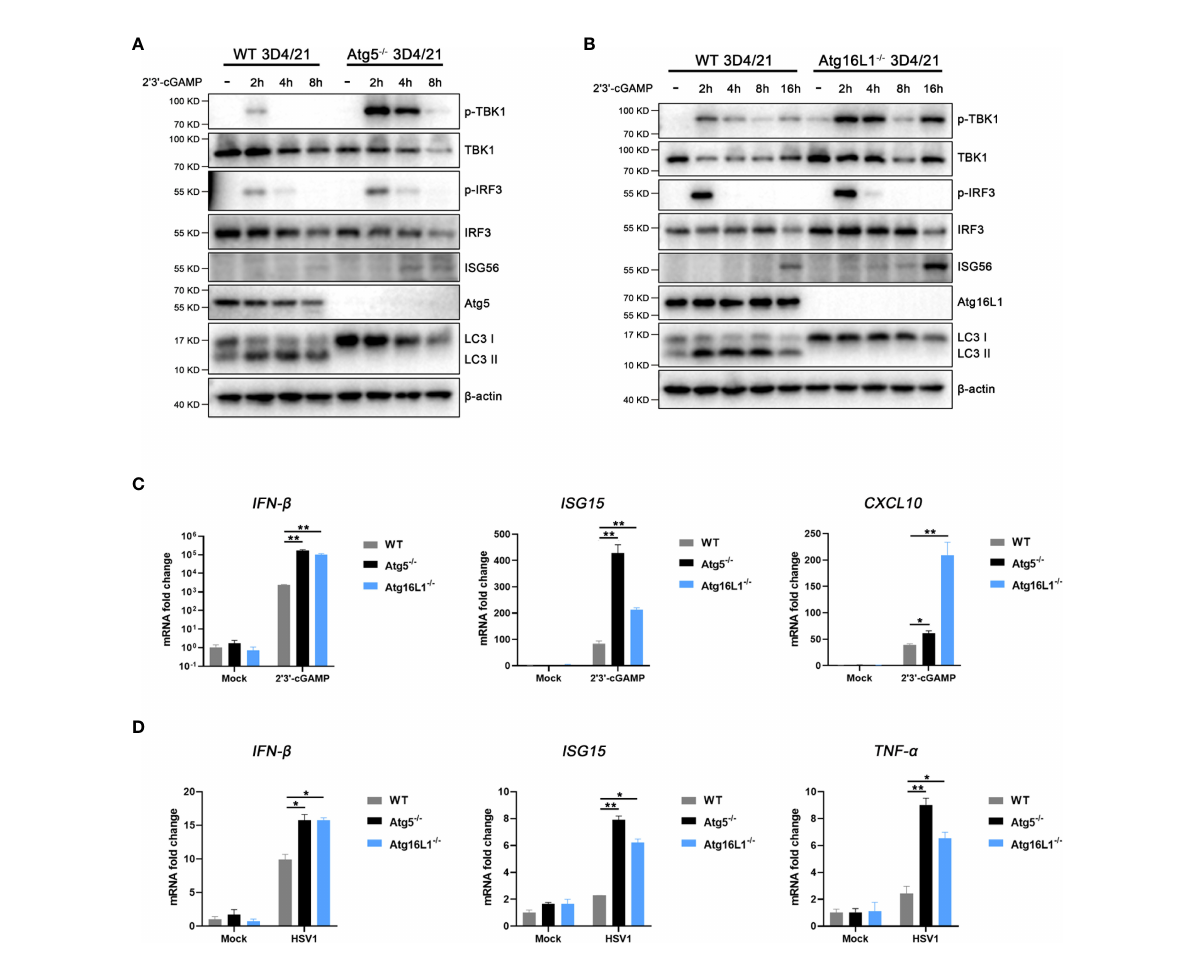
FIGURE 6 STING induced autophagy suppresses IFN signaling. (A, B) Wild type and Atg5 -/- 3D4/21 cells (A) or Atg16L1 -/- 3D4/21 cells (B) were stimulated by transfection of 2 ’ 3 ’ -cGAMP (1 m g/mL) for the indicated times, and cell lysates were analyzed by Western blotting with the indicated antibodies. (C, D) Wild-type, Atg5 -/- and Atg16L1 -/- 3D4/21 cells were stimulated with 2 ’ 3 ’ -cGAMP (1 m g/mL) for 4h (C) or infected with HSV1 (0.01 MOI) for 8 h (D) . The harvested cells were analyzed by RT-qPCR for downstream gene expressions as indicated. * p < 0.05 and ** p <